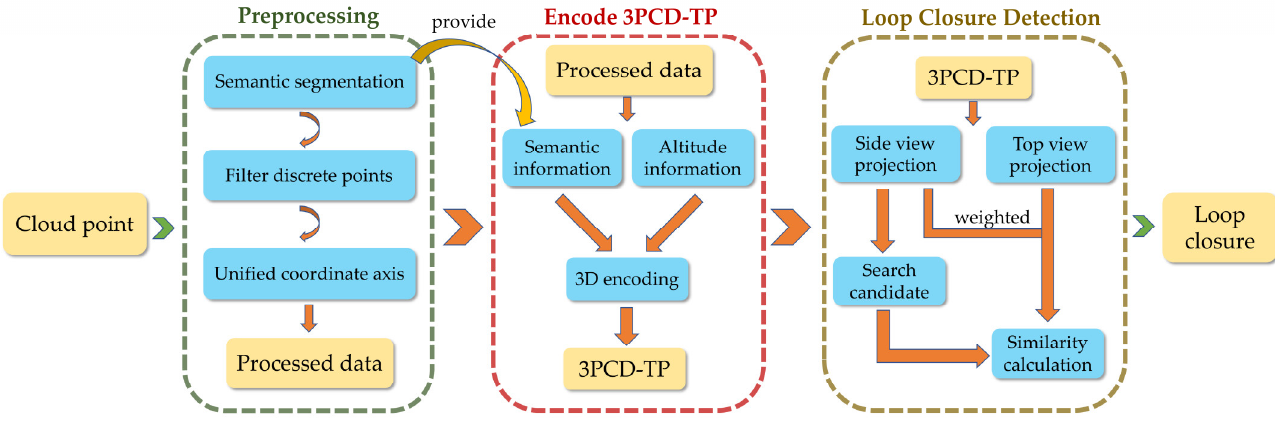
Figure 1. Pipeline of 3PCD-TP. The algorithm in this paper is broadly divided into three steps. Firstly, we pre-process the point cloud. Secondly, the height and semantic information is encoded in the processed point cloud to generate 3PCD-TP. Finally, we perform a twice projection of the descriptors, the side-view projection is used to search for candidate frames, and the weighted distance of the top-view and side-view projections are used to choose the loop